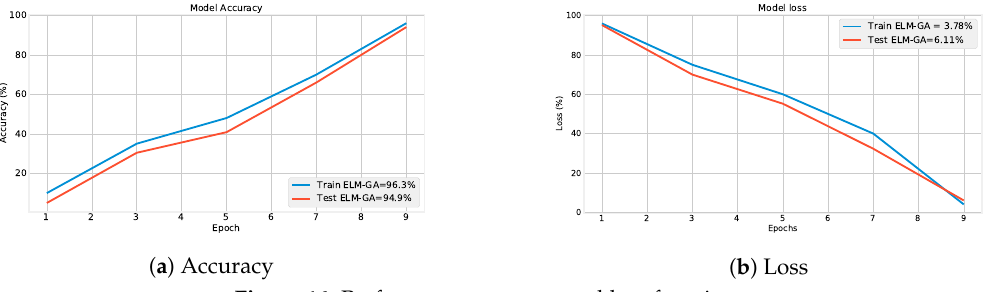
Figure 16. Performance accuracy and loss